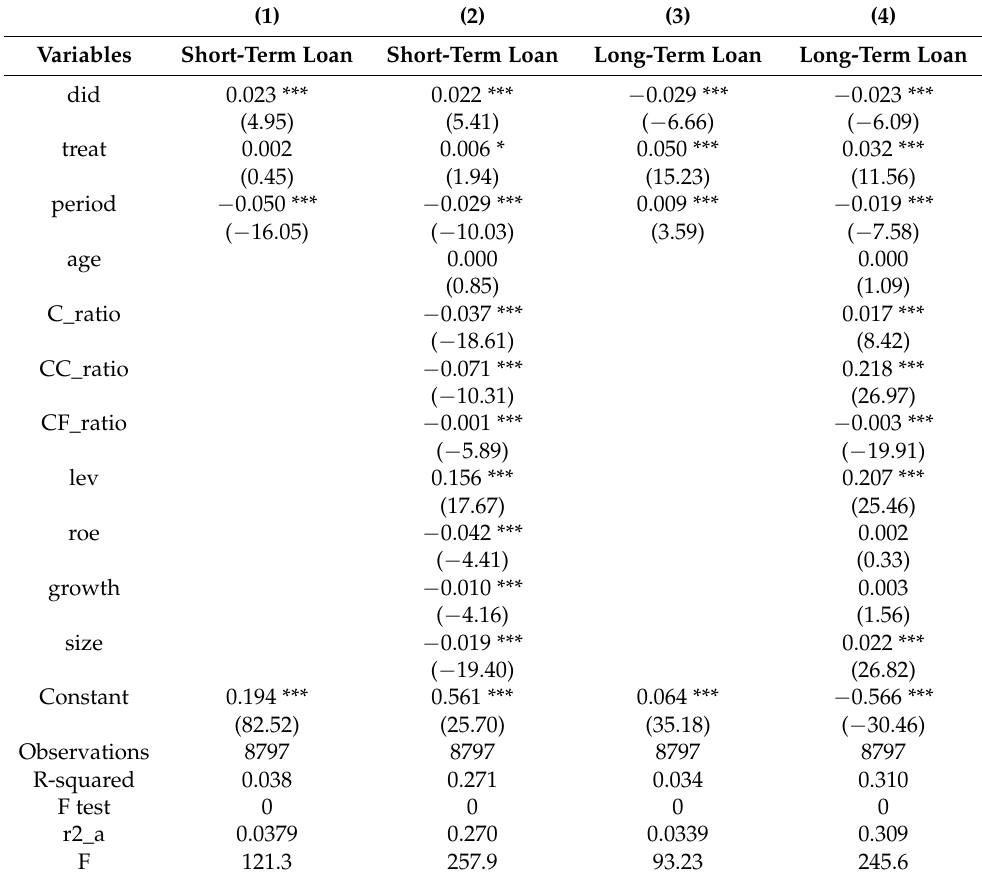
Table 5. DID test of the impact of the Green Credit Policy on short-term and long-term